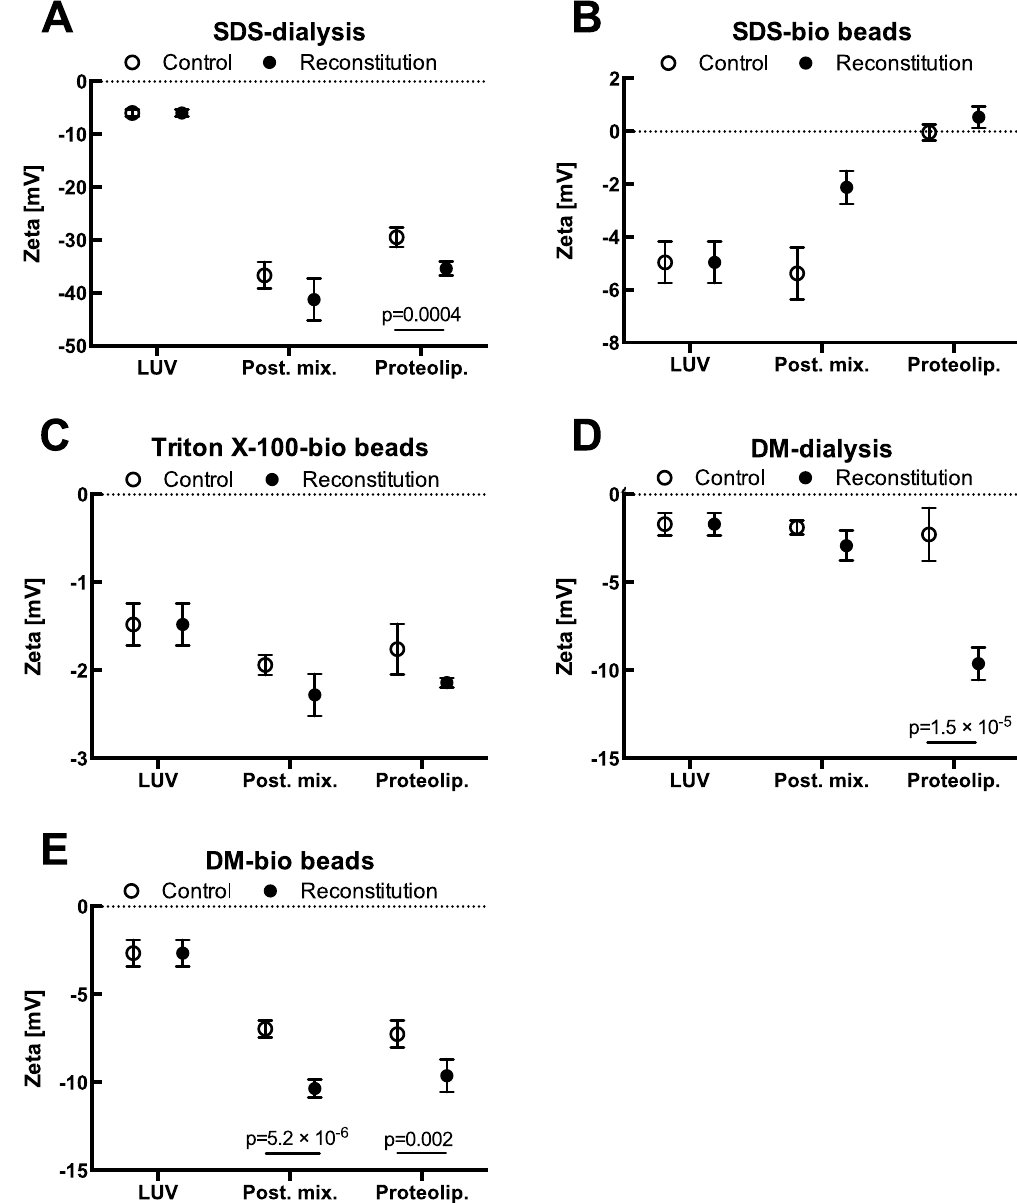
Figure 3. Zeta potential of liposomes during the reconstitution process for SDS removed by dialysis (A) or with Bio-Beads (B); Triton X-100 removed with Bio-Beads (C) and DM removed by dialysis (D) or with Bio-Beads (E). Plotted are the mean values of n=5 independent experiments with error bars depicting standard deviations. Asterisks denote significant differences between control and reconstitution experiments. LUV – initial liposome solutions (the same initial batch was measured at this point, which later was divided in two and processed in parallel for control and reconstitution experiments); Post. mix. – proteoliposomes in post-reconstitution mixture (directly after detergent removal); Proteolip. – final proteoliposomes (after centrifugation and washing). Control experiments underwent the same routine only the detergent solution without protein was added to them.